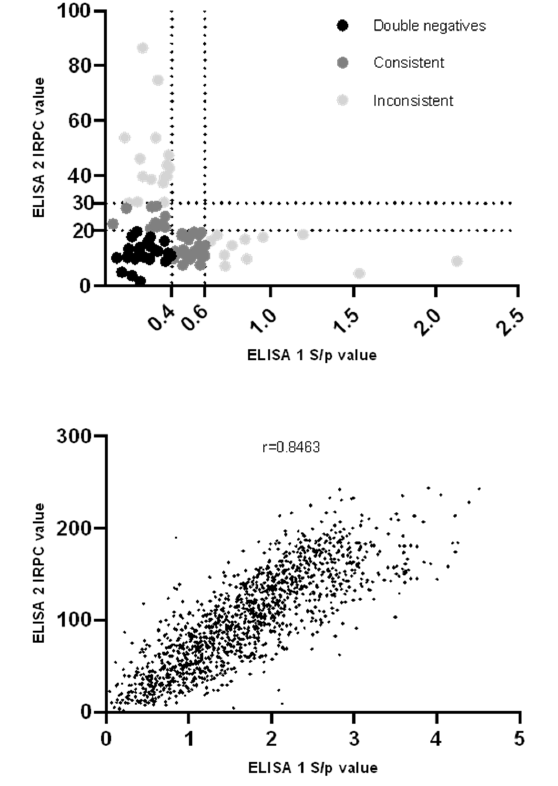
Figure 3. (Above). Overview of ELISA 1 (IDEXX PRRS X3) and ELISA 2 (CIVTEST SUIS PRRS E/S) results in the selection of 84 Porcine Reproductive and Respiratory Syndrome virus (PRRSv) vaccinated sows that tested seronegative in either or both ELISA tests. Individual sample ‐ to ‐ positive (S/p) (ELISA 1) and Relative Index Percent (IRPC) (ELISA 2) values for each sample are shown as dots. Dotted lines at S/p = 0.4 and IRPC = 20 show the cut ‐ off values for seropositivity for ELISA 1 and ELISA 2, respectively. Dotted lines at S/p = 0.6 and IRPC = 30 show the cut ‐ off values for low seropositivity for ELISA 1 and ELISA 2, respectively. Twenty ‐ three sows were classified as being seronegative in both ELISA tests (double ‐ negatives, black dots), 34 sows were classified as being seronegative in one ELISA test and low ‐ seropositive in the other ELISA test (consistent results, dark grey), 27 sows were classified as being seronegative in one ELISA test and seropositive in the other ELISA test (inconsistent results, light grey). (Below). Overview of ELISA 1 (IDEXX PRRS X3) and ELISA 2 (CIVTEST SUIS PRRS E/S) results in 1400 sow samples originating from 70 Belgian sow herds that practice routine PRRSv vaccination. Individual sample ‐ to ‐ positive (S/p) (ELISA 1) and Relative Index Percent (IRPC) (ELISA 2) values for each sample are shown as dots. An overall Spearman correlation of r=0.846 (CI 95% [0.830, 0.861], p < 0.0001) between ELISA 1 and ELISA 2 was found. 3.6. Confirmation of ELISA 1 and/or ELISA 2 Non ‐ Responders in ELISA 3 and ELISA 4 Seronegative samples in either ELISA 1 and/or ELISA 2 were further analyzed using two additional ELISA kits (Table 3) to confirm their seronegative status. Of the 23 E1 − /E2 − sows, 22/23 (95.65%) tested seronegative in ELISA 3, with one seropositive sample just above the cut ‐ off value: S/p value = 0.41. In ELISA 4, 21/23 (91.3%) E1 − /E2 − sows were classified as seronegative, with two seropositive samples having S/p values of 0.75 and 1.08. The E1 − /E2+ sows mostly tested seronegative in the additional kits as well: 25/26 (96.15%) were seronegative in ELISA 3, and 24/26 (92.31%) tested seronegative in ELISA